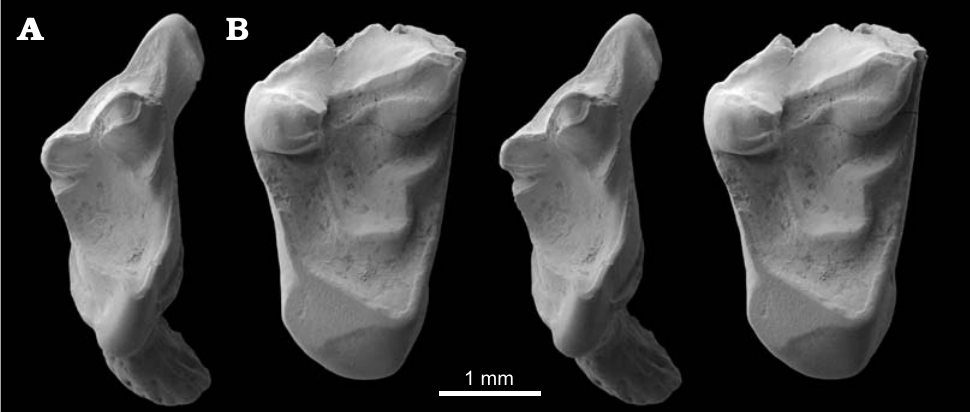
Fig. 4. Stereo scanning electron micrographs of studied eutherian mammal specimens from the Ber riasian Purbeck Group of Dorset, southern England; in